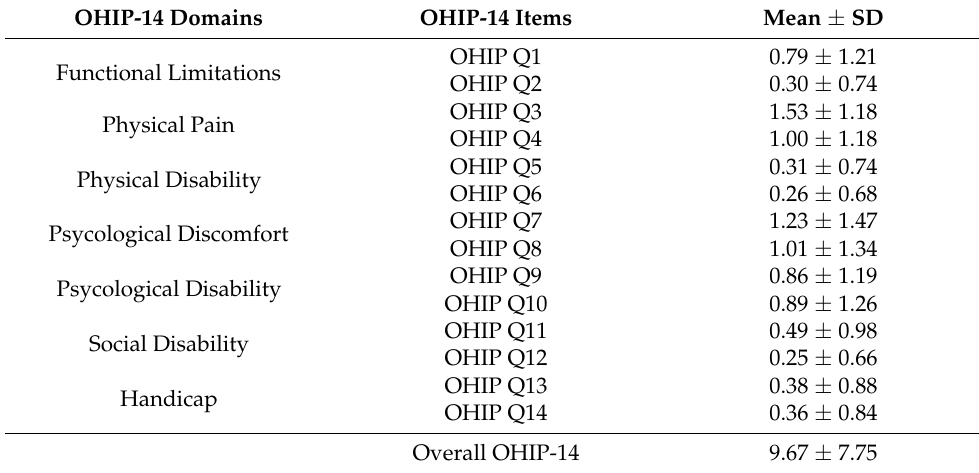
Table 4. Mean score of the individual and overall OHIP-14 items of the participants.